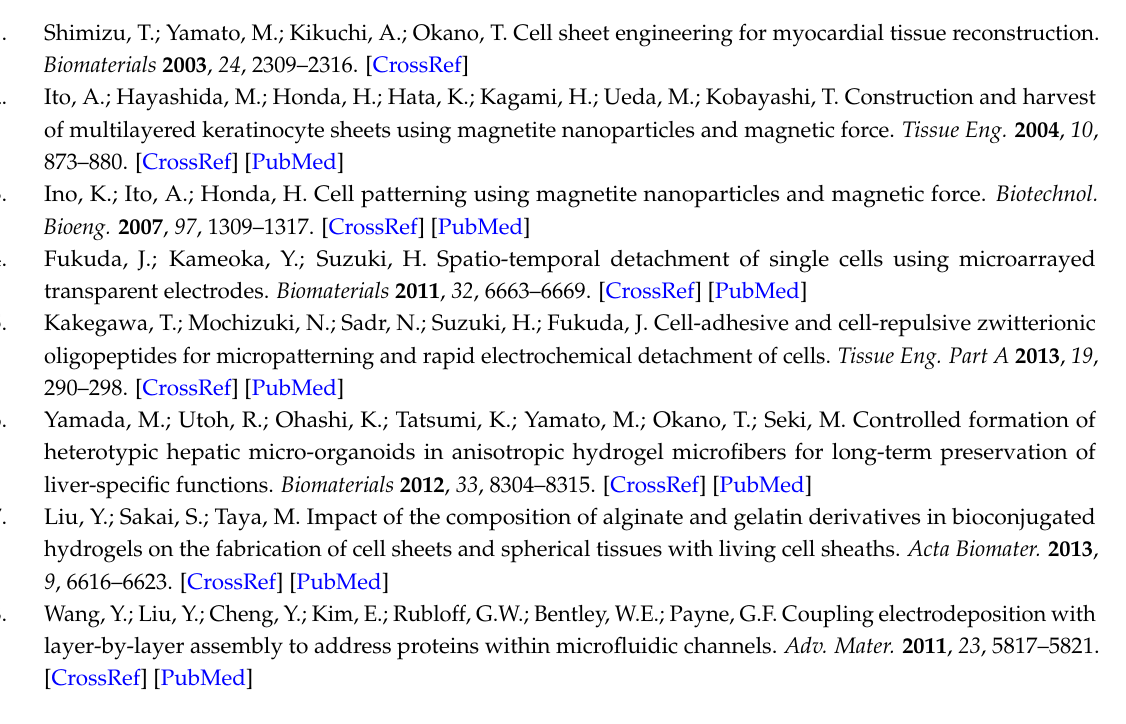
Figure S1: Schematic illustration and picture for electrochemical lithography. The electrode was manually positioned and scanned. For the precise control, an xyz-stage is necessary, Figure S2: Procedure for the direct electrodeposition of calcium-alginate hydrogels. Ca 2+ is produced from the reaction between CaCO 3 and electrolytically-generated H + from water. The generated Ca 2+ reacts with alginate directly, forming a hydrogel on the electrode. This method has been previously reported. and 16H02280) and for Young Scientists (B) (No. 23760745) from the Japan Society for the Promotion of Science